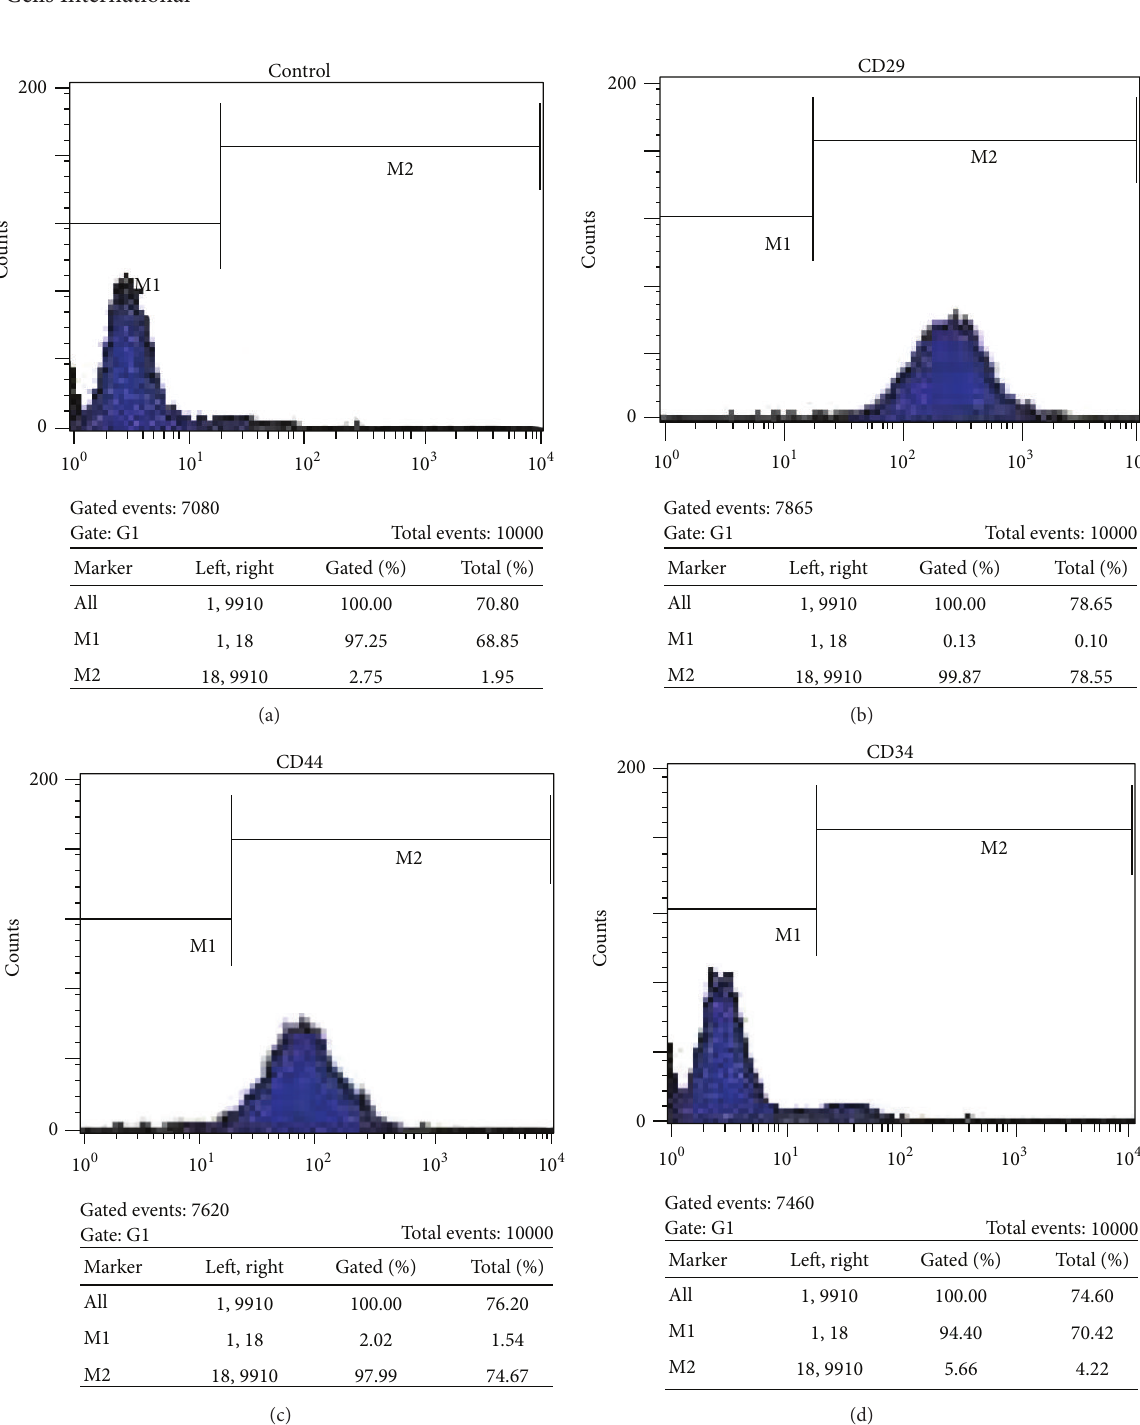
Figure 1: Graphs showing expression of mesenchymal stem cell markers (CD29 and CD44) and hematopoietic stem cell marker (CD34). Filled area shows the expression of target marker. High percentage of cells expressed CD29 and CD44, whereas only few cells expressed